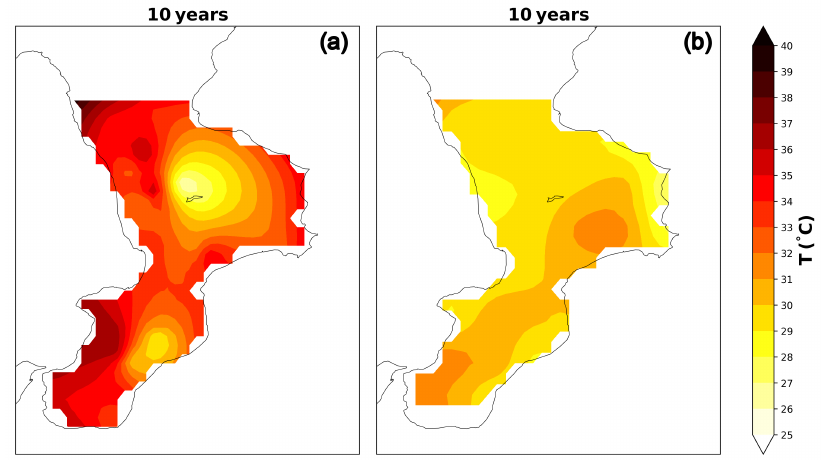
Figure 8. Comparison between the daily max temperature return-level maps for a return period of 10 years. Return-level maps for the observed data ( a ) and for the ERA5 data ( b